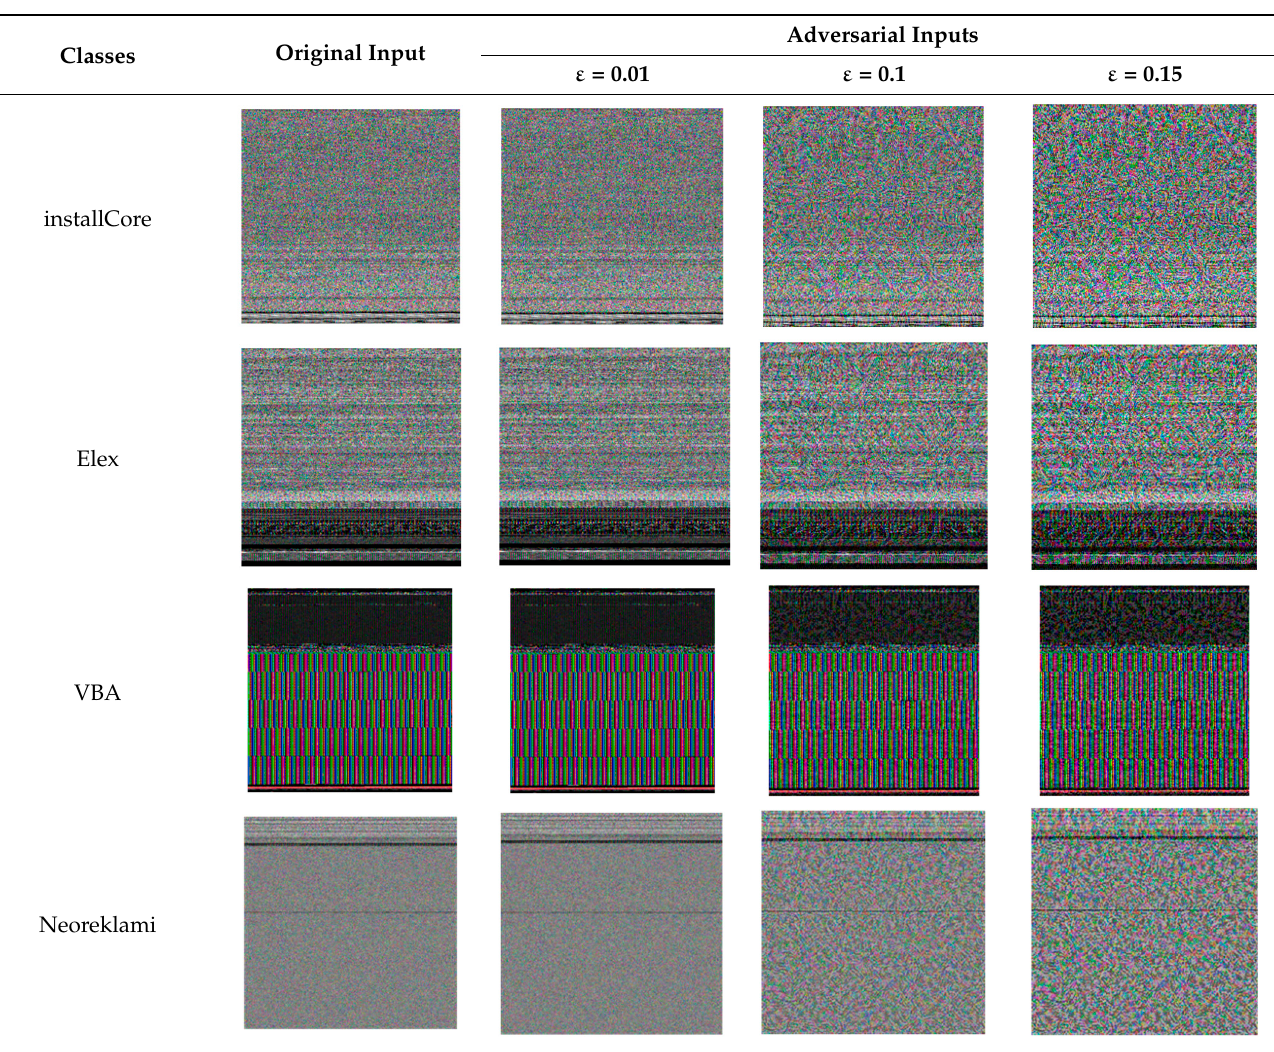
Table 4. Adversarial input generation.